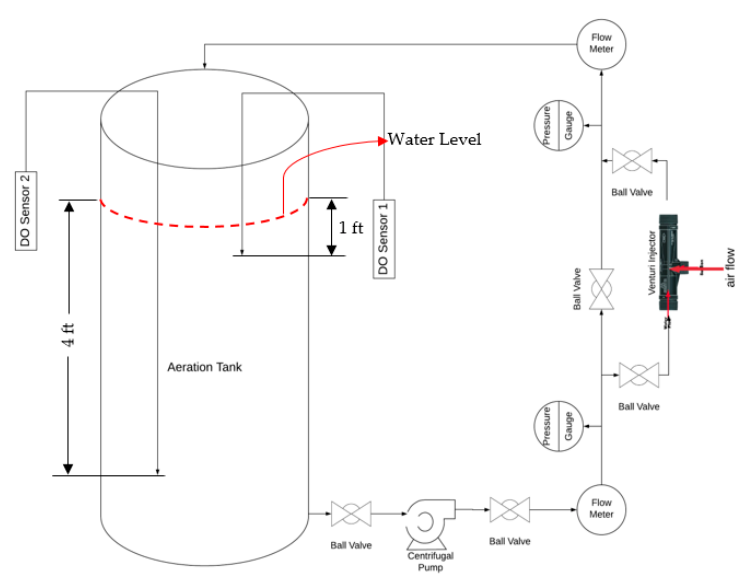
Figure 1. Schematic of Current Experimental Setup.